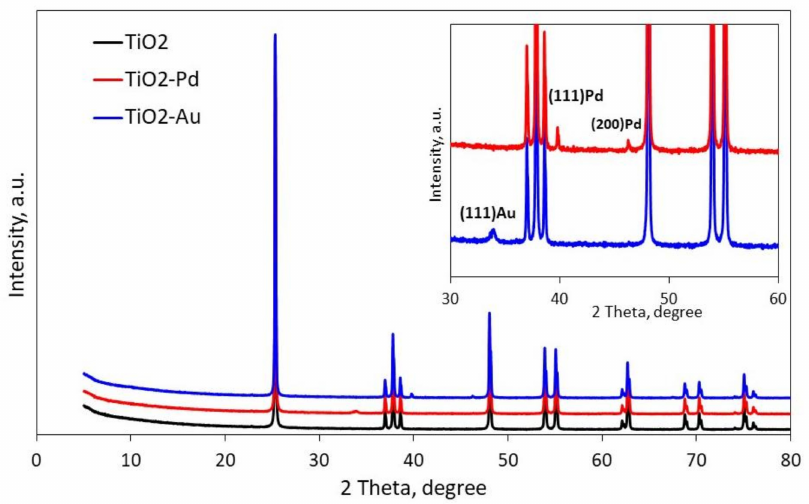
Figure 2. XRD pattern of TiO 2 support, TiO 2 -Pd/incipient wet impregnation (IWI) and TiO 2 -Au/IWI, calcined at 600 ◦